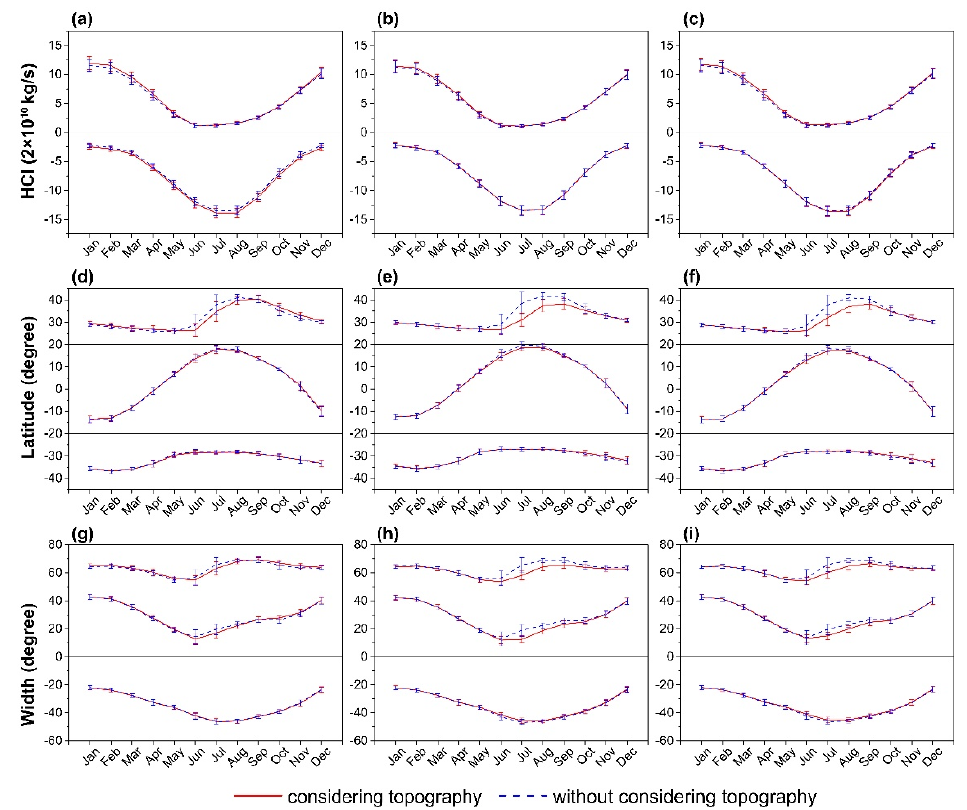
Figure 6. ( a – c ) Annual cycle of the NH (upper) and SH (lower) HCI derived from ( a ) M1, ( b ) M2, and ( c ) M3 using the MRM data sets from 1979–2018. The red, solid line and blue, dashed line represent the annual cycle of the HCI without and with considering FBGMW, respectively. ( d – f ) Same as ( a – c ) but for the annual cycle of the NE (upper), CE (middle), and SE (lower). ( g – i ) Same as ( a – c ) but for the annual cycle of the TOT (upper), NH (middle), and SH (lower) HCW. The vertical bars in each plot represent the standard deviation of the interannual variability. The units for the HCI are 2 × 10 10 kg/s, and the units for the NE, CE, SE, TOT HCW, NH HCW, and SH HCW are degrees.